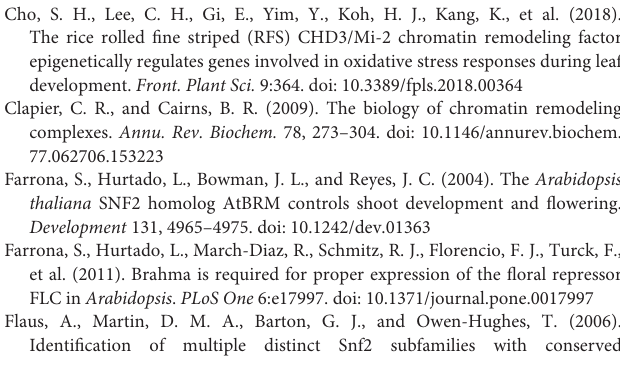
Supplementary Figure 1 | The relative expression level of Snf2 gene family in the stamen. (A) Preferentially expressed Snf2 genes at the An1, An5, and An6 stages.